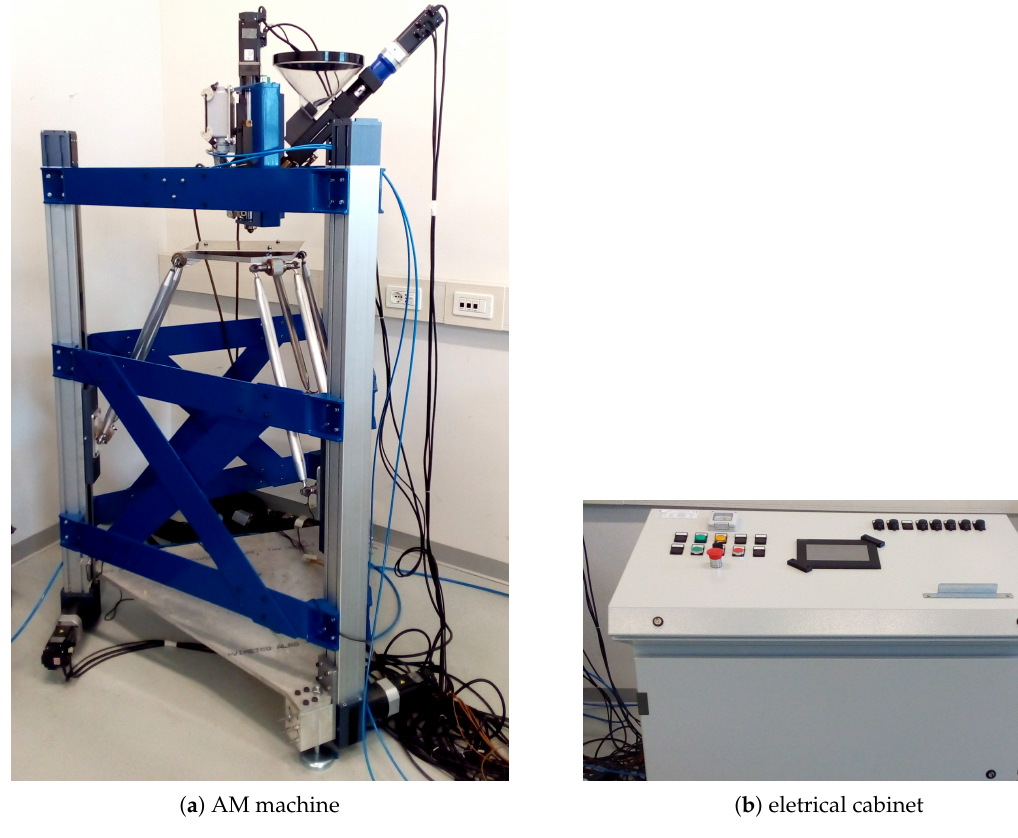
Figure 12. AM machine based on a MIM extruder